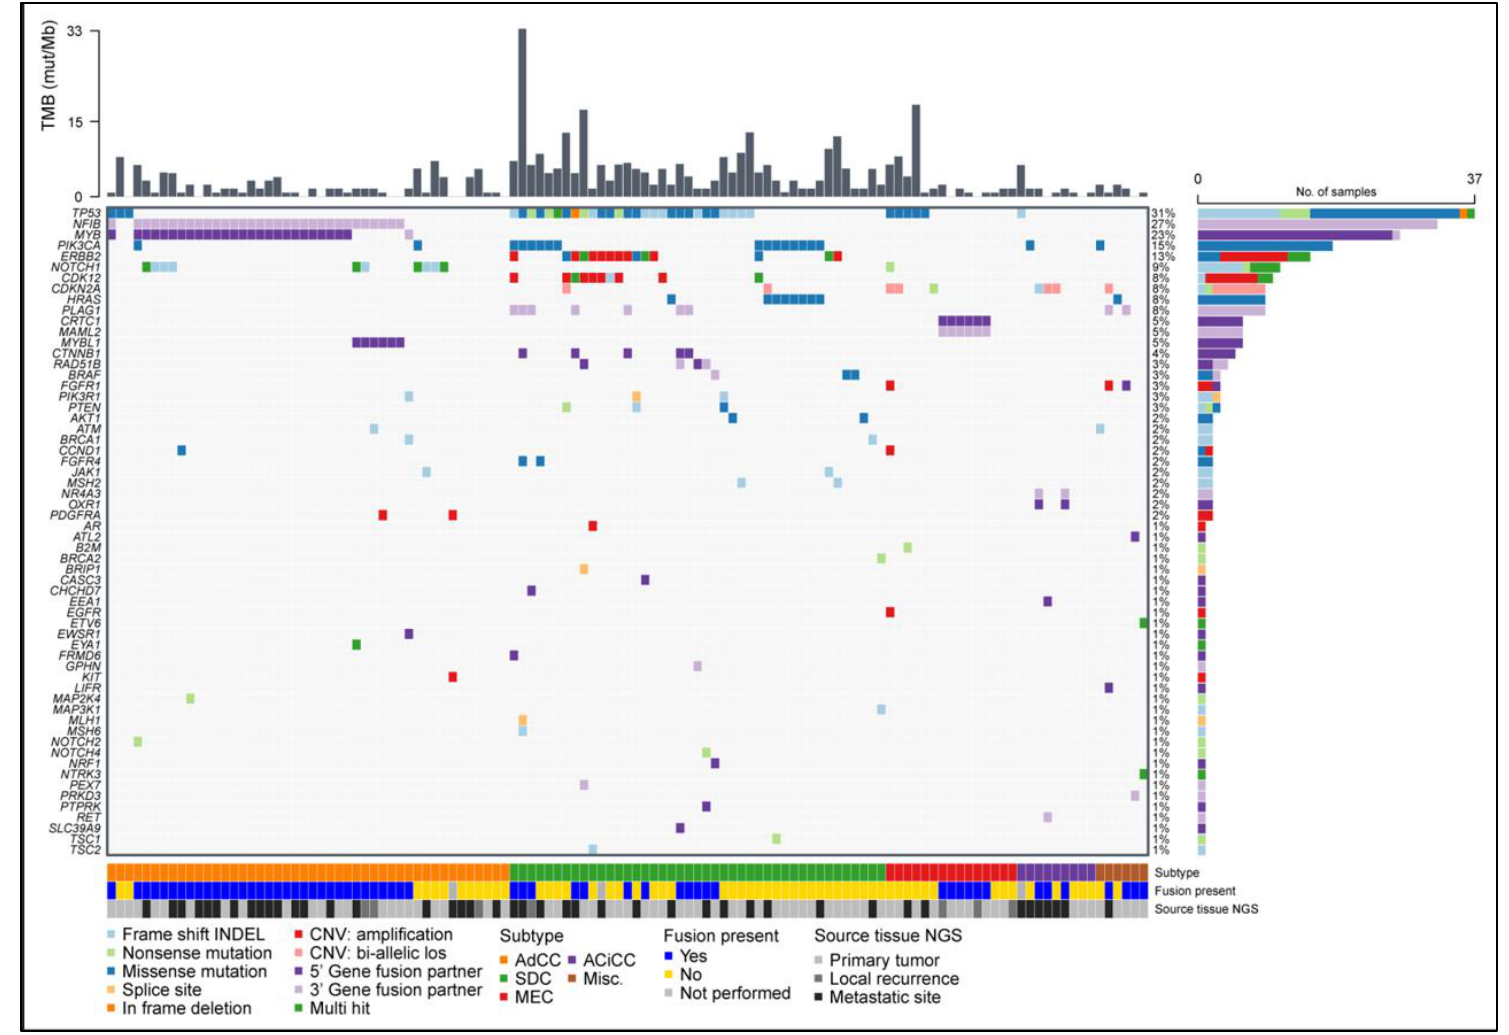
Figure 2. Oncoplot of all gene fusions, copy number variants and small variants that are assessed as pathogenic or likely pathogenic. AdCC: adenoid cystic carcinoma, SDC: salivary duct carcinoma, MEC: mucoepidermoid carcinoma, AciCC: acinic cell carcinoma, Misc.: miscellaneous. 3.3. Frequent Detection of MYB- and MYBL1-NFIB Fusion Transcripts in AdCC In AdCC, all identified fusion transcripts involved MYB or MYBL1, fused to NFIB ( n = 33) and fusions involving these genes were exclusive to AdCC cases . Fusions with MYB or MYBL1 gene as 5′ partner and NFIB as 3′ partner were detected most frequently ( n = 32, Figures 2 and 3). In most of these cases ( n = 22) one or more alternative fusion transcripts involving the same genes were detected, with different breakpoints, indicating alternative or aberrant splicing of the fusion transcripts. One in-frame EWSR1-MYB fusion transcript was detected, with MYB as 3′ partner , leaving the MYB coding sequence largely intact